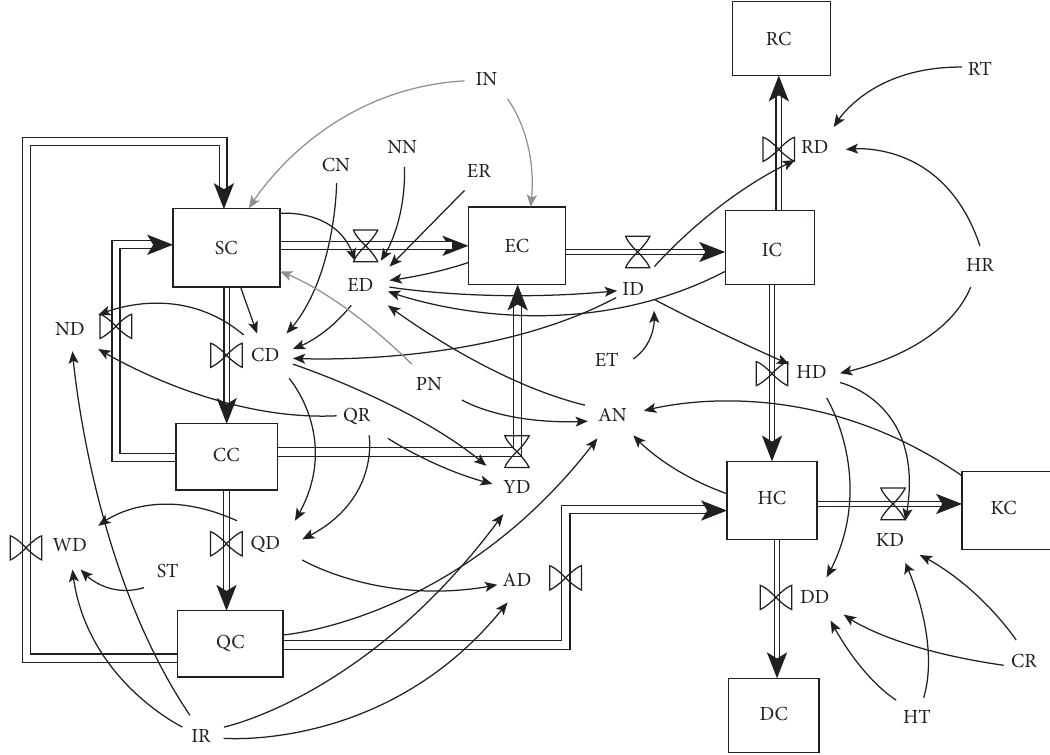
Figure 7: System flowchart of the improved SEIR-SD